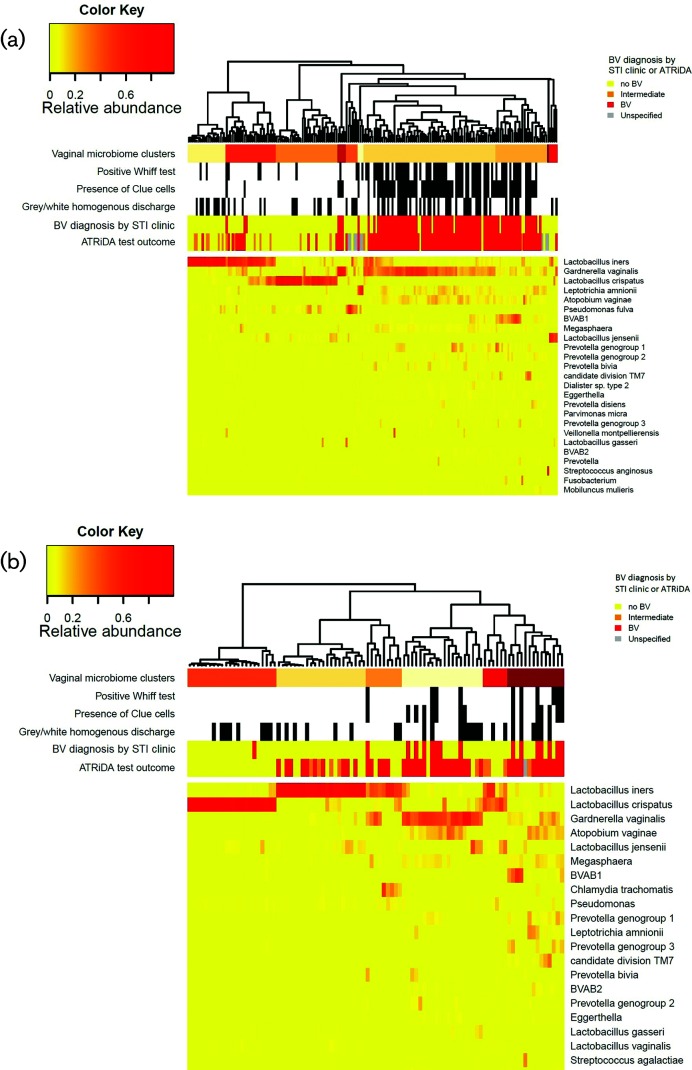
Heatmap depicting microbial species (y-axis) per sample (x-axis) of a) women reporting urogenital symptoms and b) women notified for an STI. Microbial relative abundance is illustrated by the colour key. Sidebars above the heatmap depict vaginal microbiome clusters (top bar), BV clinical parameters and clinical BV diagnosis as recorded in the electronic patient file (middle bars) and ATRiDA test outcome (bottom bar).